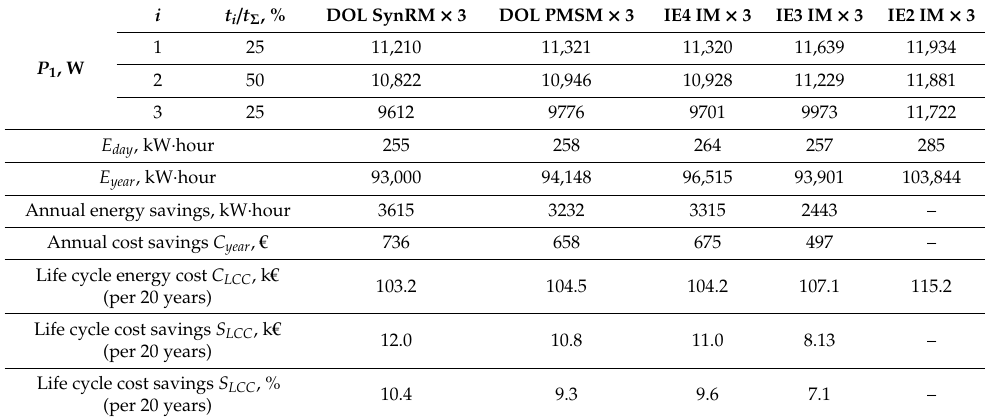
Table 6. Calculation of the energy consumption of one pump unit excluding the cable and transformer losses (case 1, m = 1) [50].